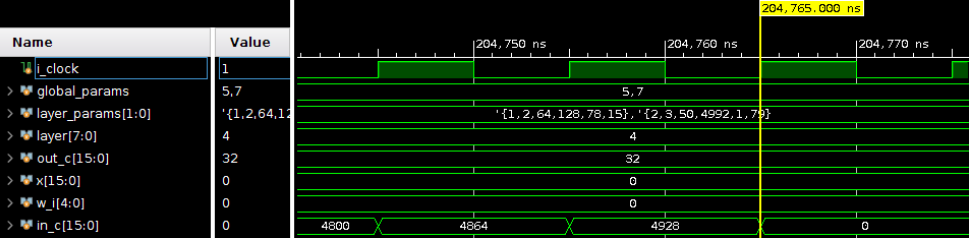
Figure 5. Simulation snapshot of the IP core @ 100 MHz showing the end of the computation of the last